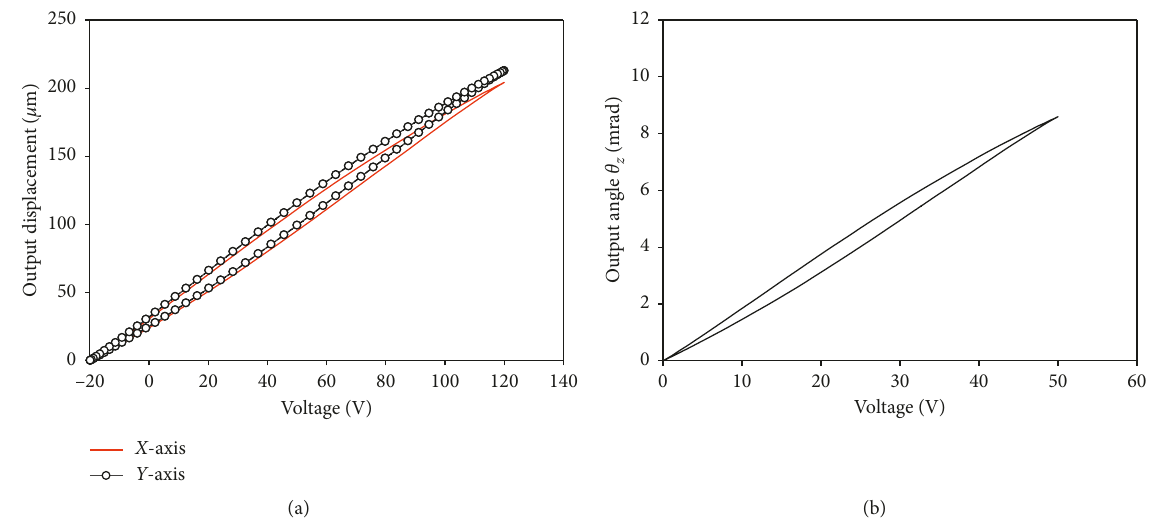
Figure 18: Tested output displacements in (a) X and Y directions and (b) θ